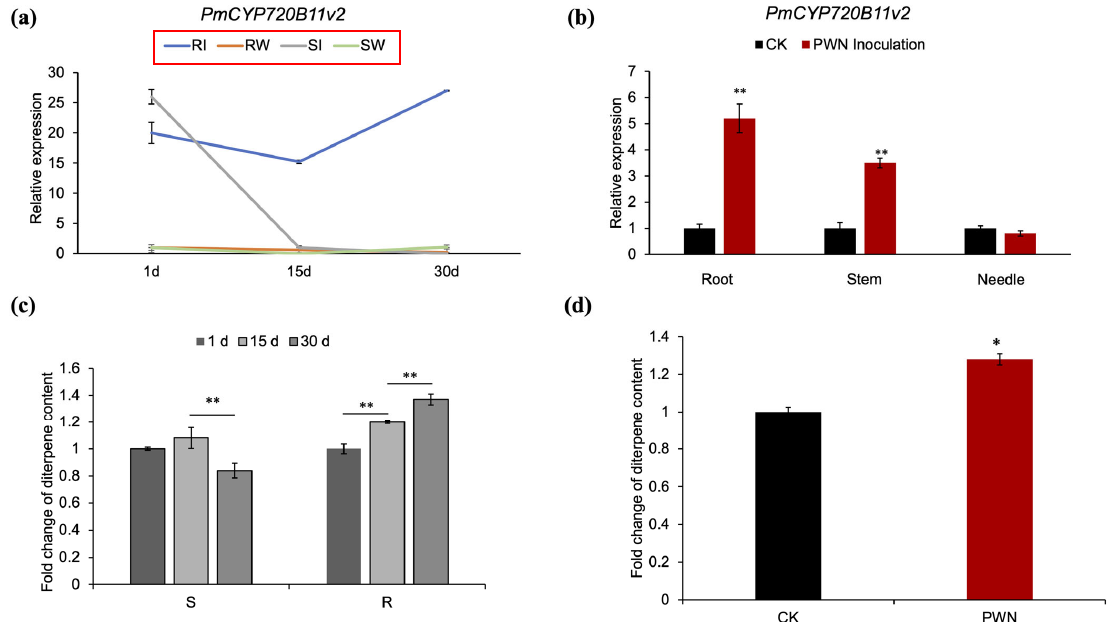
Figure 2. Tissue-specific expression patterns of PmCYP720B11v2 and analysis of diterpene changes in P. massoniana following PWN inoculation. ( a ) The transcript levels of PmCYP720B11v2 in resistant and susceptible P. massoniana after inoculation with PWN. Error bars represent ± SD from three biological repeats. RI, resistant P. massoniana inoculated with B. xylophilus ; RW, resistant P. massoniana inoculated with water; SI, susceptible P. massoniana inoculated with B. xylophilus ; SW, susceptible P. massoniana inoculated with water. ( b ) The transcript levels of PmCYP720B11v2 in different tissues of resistant P. massoniana . ( c ) Content fold change of diterpenes in resistant P. massoniana and susceptible P. massoniana after inoculation with PWN at 1, 15, and 30 days. ( d ) Content fold change of diterpenes in resistant P. massoniana . Error bars represent ± SD from three biological repeats. Root; Stem; Needle; CK, controls: resistant P. massoniana inoculated with water as a control; PWN Inoculation: resistant P. massoniana inoculated with PWN over 2 years. Asterisks indicate statistically significant differences from lines expressing PmCYP720B11v2 genes based on Student’s t ‐ test s (*, p < 0.05; **, p < 0.01).